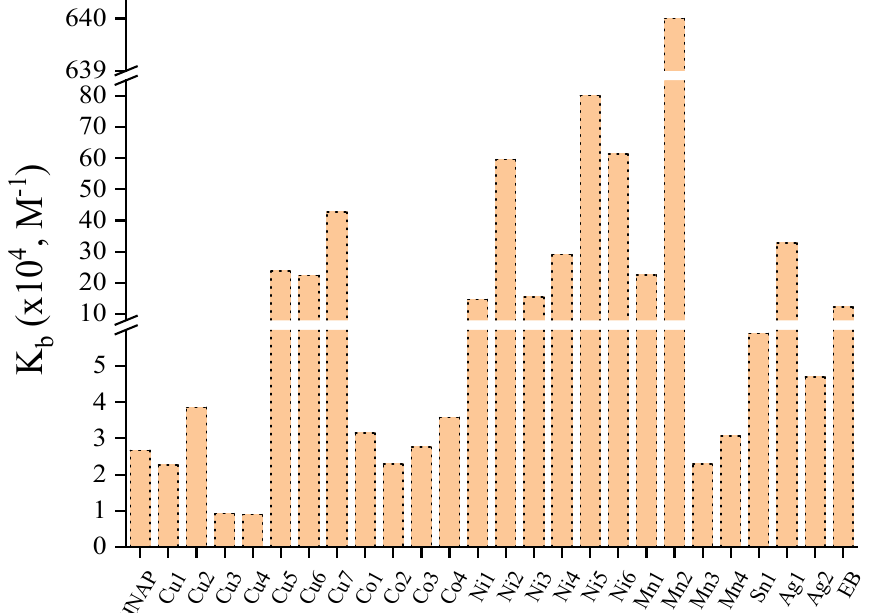
Figure 28. DNA–binding constants (K b ) for naproxen and its reported complexes. (Codes of compounds: HNAP = naproxen; Cu1 = [Cu 2 (NAP) 4 (H 2 O) 2 ]; Cu2 = [Cu(NAP) 2 (bipy)]; Cu3 = [Cu(NAP) 2 (phen)];